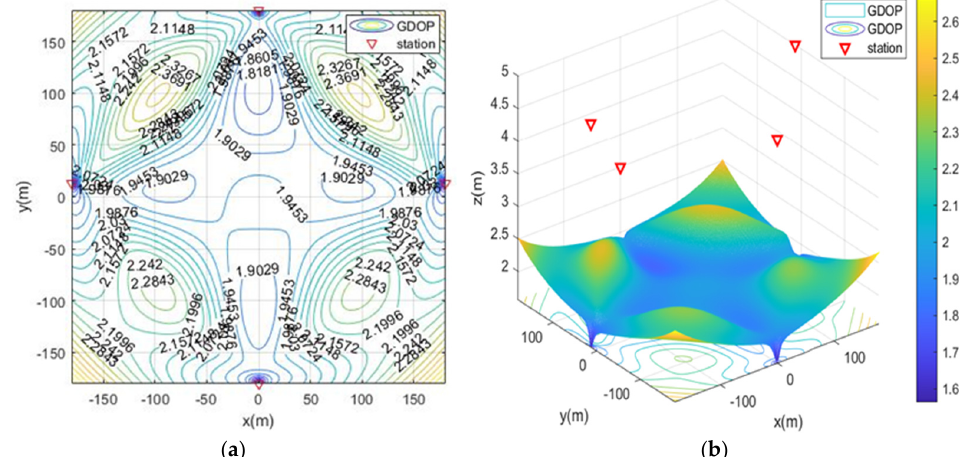
Figure 4. The geometric dilution of precision (GDOP) of MOA optimized station deployment in scenario 1. ( a ) 2D contour map; ( b ) 3D contour map.